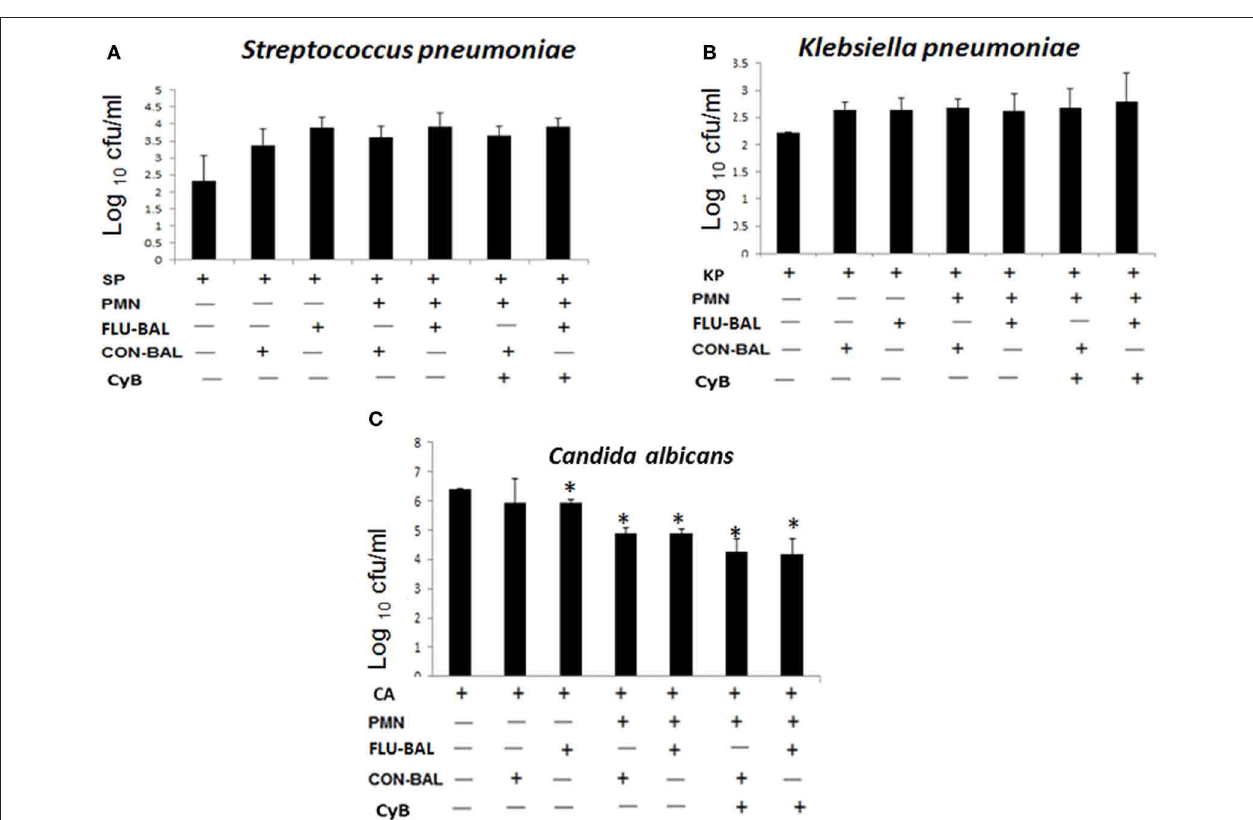
FIGURE 5 | Bactericidal and fungicidal activities of neutrophils and NETs in vitro . To determine the antimicrobial activity of NETs, neutrophils (PMN) were incubated with virus-infected BALF (FLU-BALF) or uninfected control BALF (CON-BALF) in the presence of (A) S. pneumoniae 19F or SP, (B) K. pneumoniae K15 or KP, and (C) C. albicans or CA with or without cytochalasin B (CyB). After incubation for 2.5h, the remaining